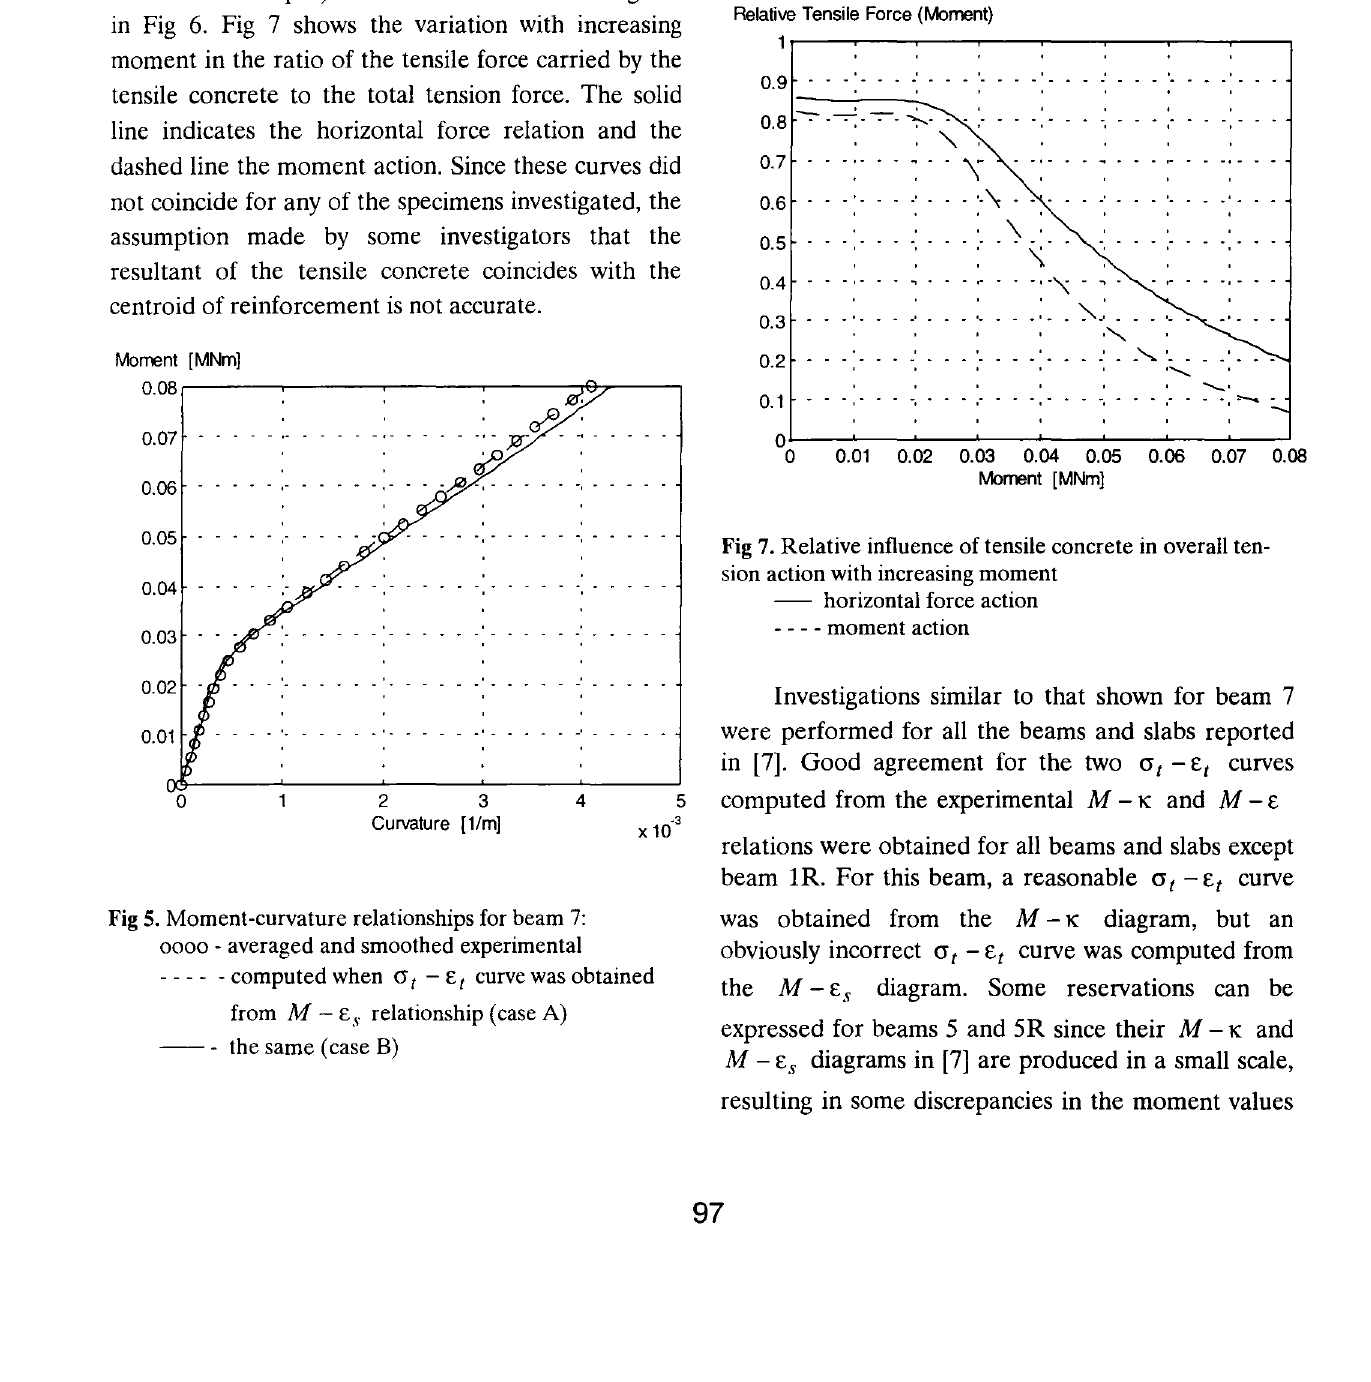
Fig 6. Relative depth of the compressive zone with increas ing moment Relative Tensile Force (Moment)